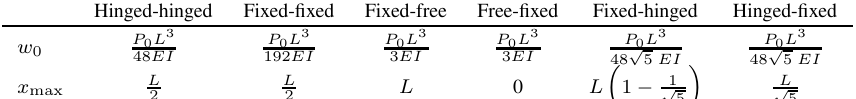
Table 1 Maximum static de fl ection and its corresponding location of the studied beams